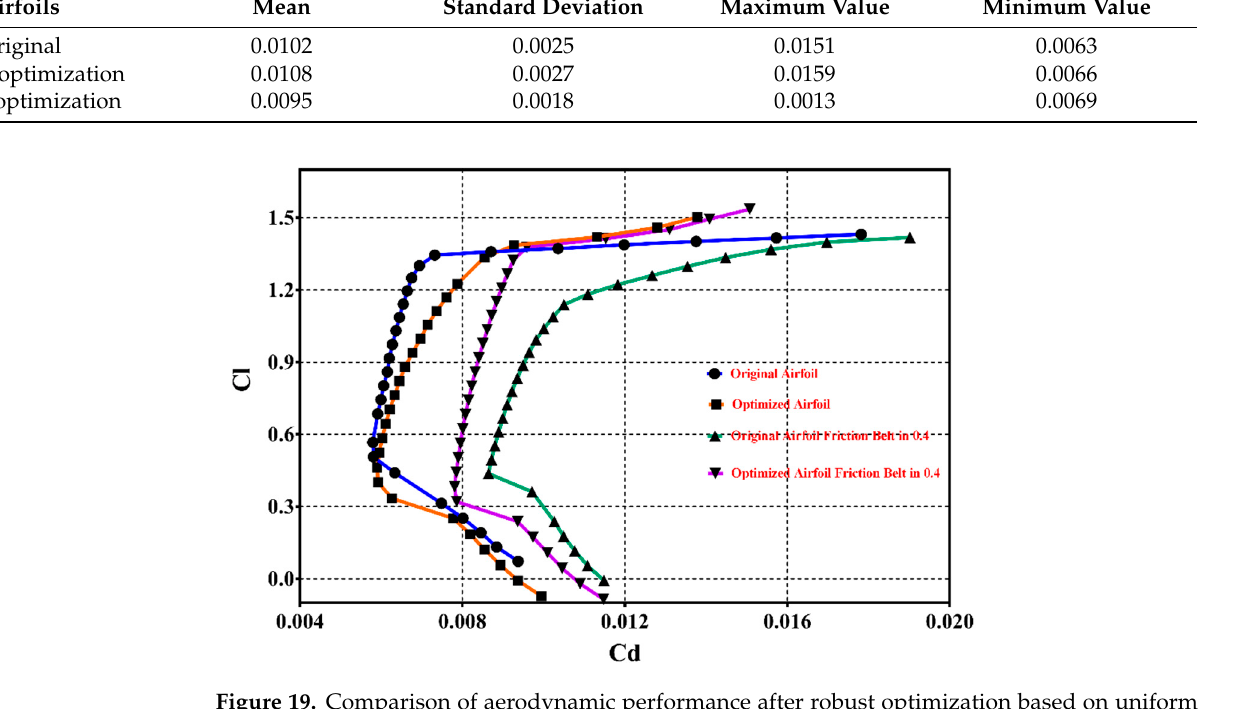
Figure 19. Comparison of aerodynamic performance after robust optimization based on uniform probability distribution.